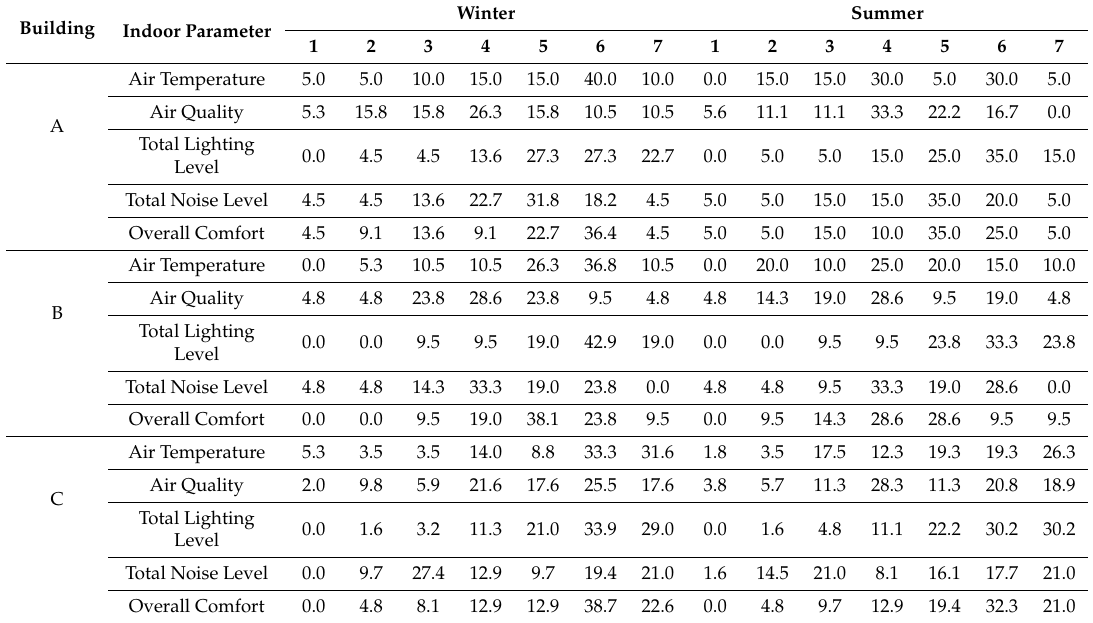
Table 6. Results of the descriptive analysis for the indoor conditions during winter and summer period, per Building (in